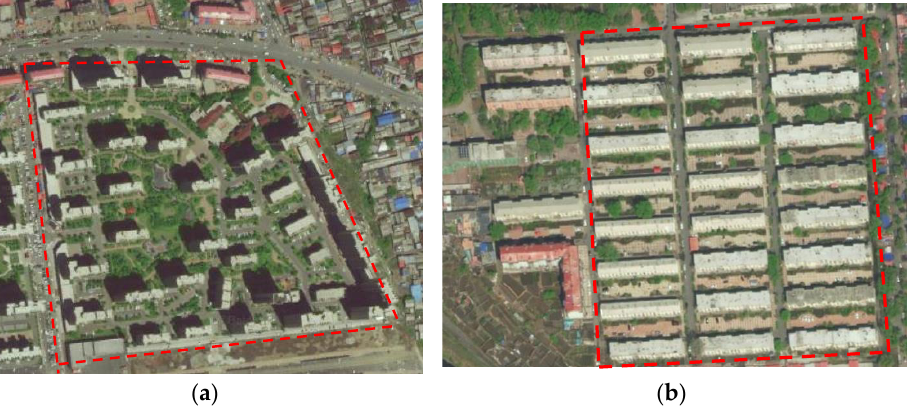
Figure 1. Actual building layouts in Harbin, China, with ( a ) distorted wind passages and ( b ) stream- lined wind passages.